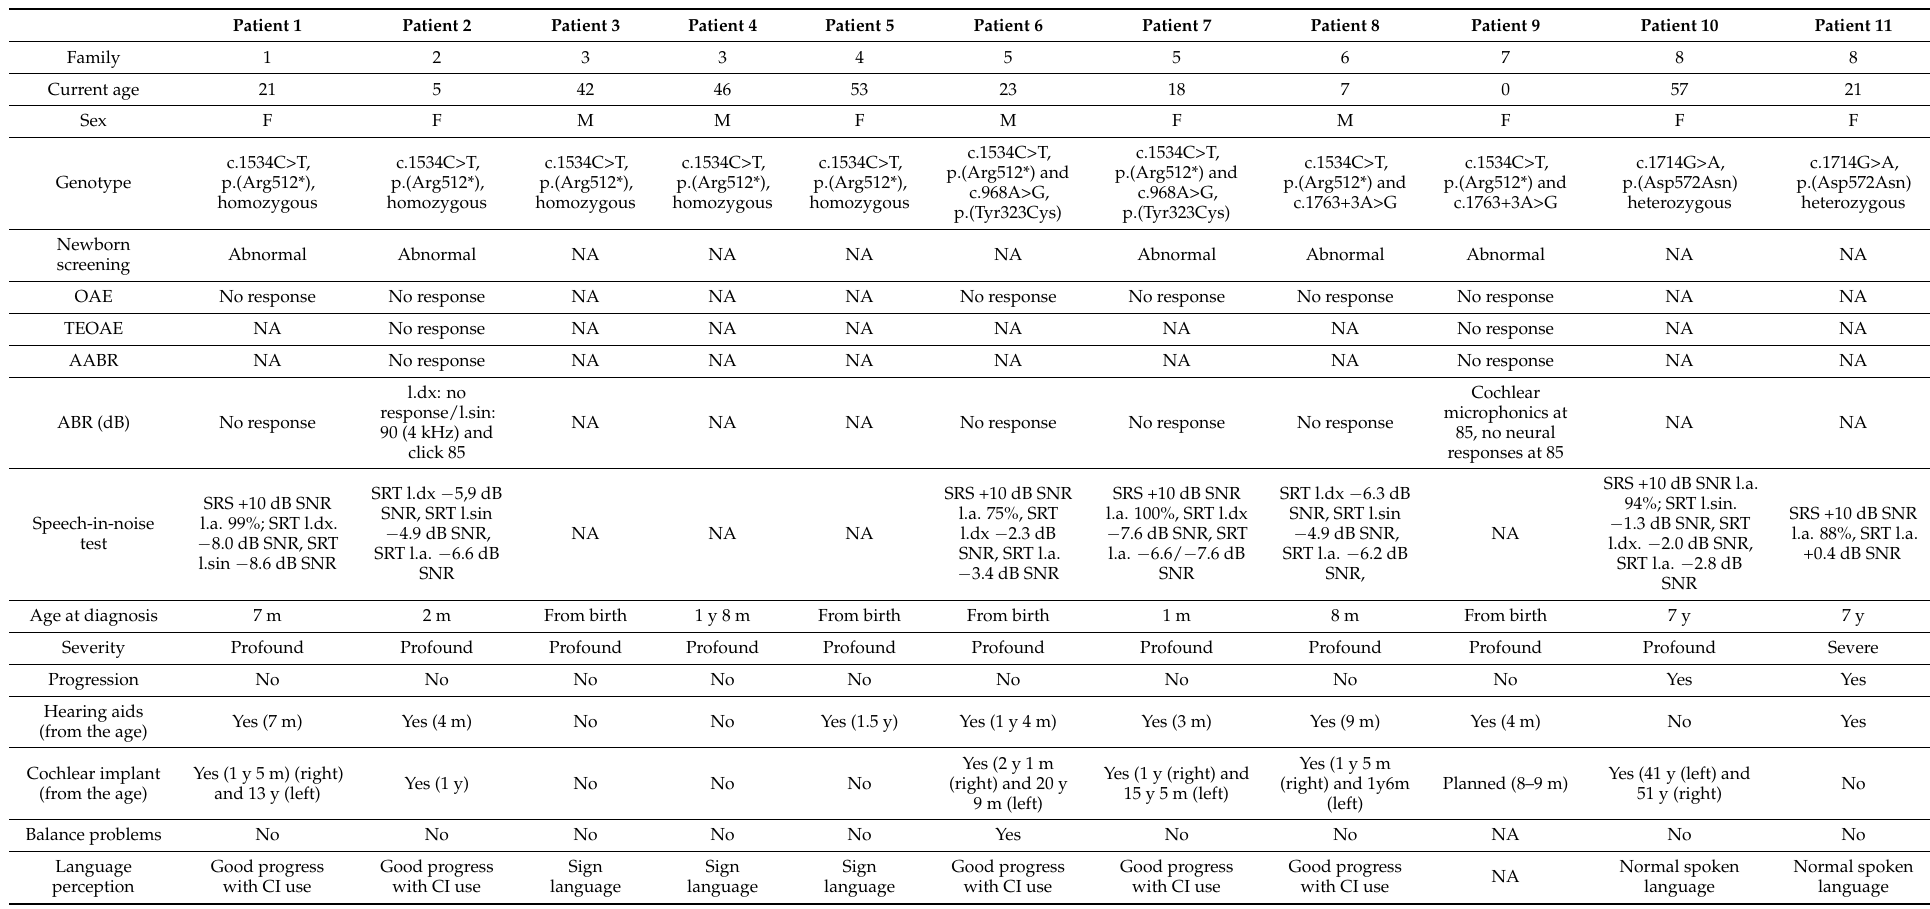
Table 1. Clinical characteristics of patients. Patients 1–9 had recessively inherited sensorineural hearing loss associated with biallelic pathogenic recessive TMC1 variants. Patients 10 and 11 had a dominantly inherited hearing loss associated with a heterozygous pathogenic TMC1